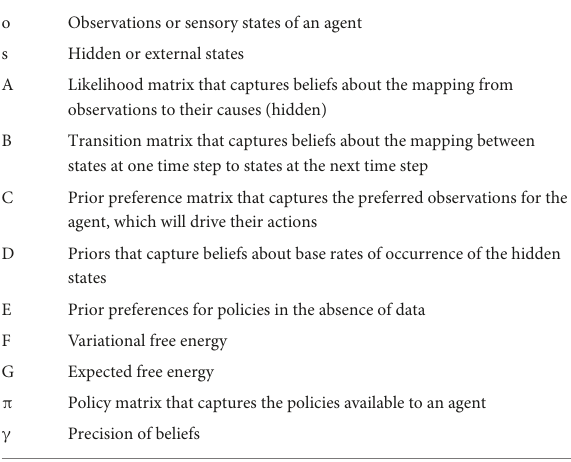
TABLE 1 Parameters used in the general model under the active inference